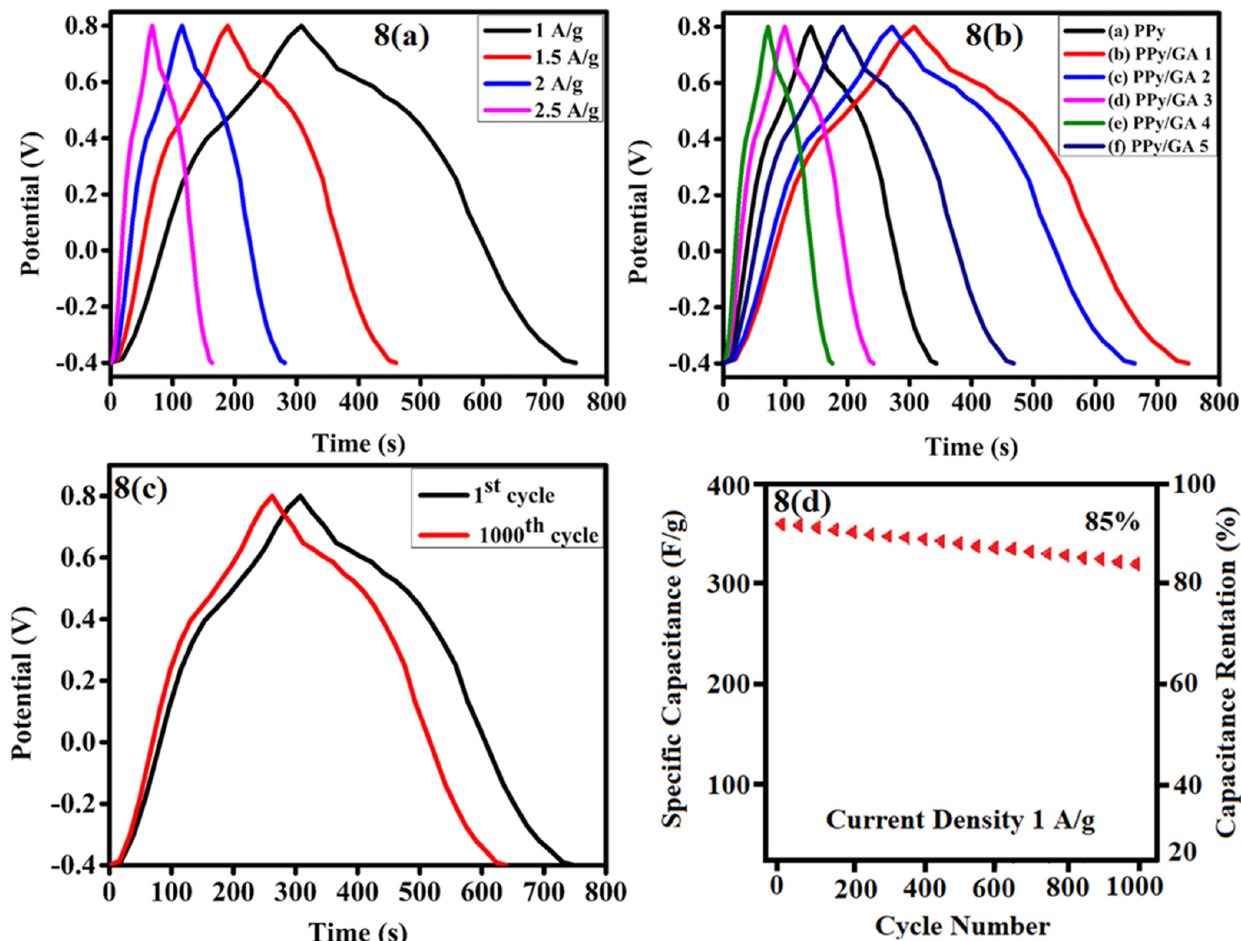
Figure 8. ( a ) GCD curves of PPy/GA 1 composite at different current densities. ( b ) GCD curves of neat PPy and PPy/GA composites at 1 A/g current density. ( c ) GCD curves of PPy/GA 1 for 1st and 1000th cycles at 1 A/g current density. ( d ) Plot of specific capacitance and capacitance retention versus cycle number.